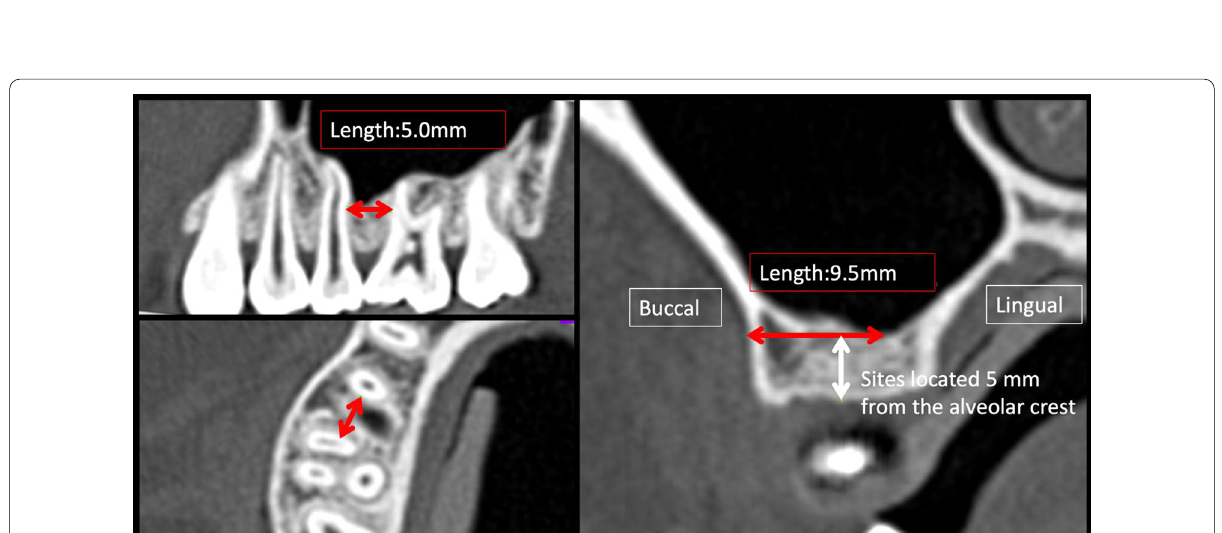
Fig. 3 Measurements on CT images. Maxillary buccal alveolar bone thickness and distance between the roots of the maxillary second premolar and first molar at 5, 6.5, and 8 mm from the alveolar crest were measured on CT